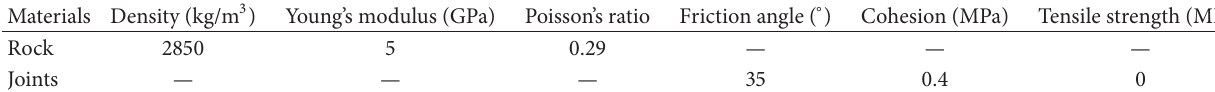
Table 1: Mechanical parameters of rock and joints.